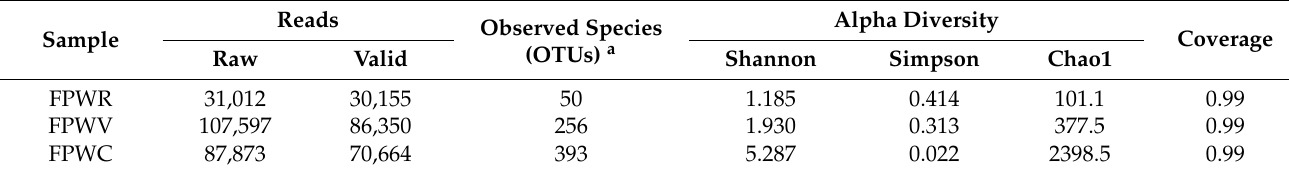
Table 1. Comparison of diversity of microorganisms isolated from different food process wastes (FPWs); used rice grounds (FPWR); vegetable by-product (FPWV); and compost (FPWC).